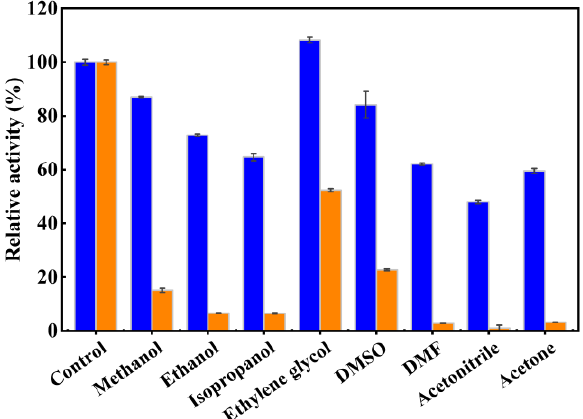
Figure 6. Effects of organic solvent on enzymatic activities of arylesterase LggEst wild type and the deleted mutant. Enzymatic activity by adding the corresponding volume of water is taken as the control. All reactions were performed in triplicate, and error bars represent the standard deviations of mean. The enzymatic activities for LggEst wild type and the deleted mutant are shown in blue and orange, respectively.